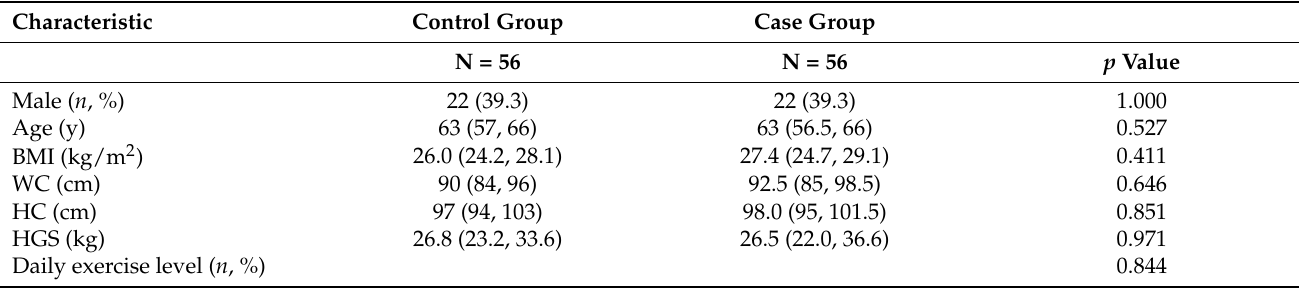
Table 1. General